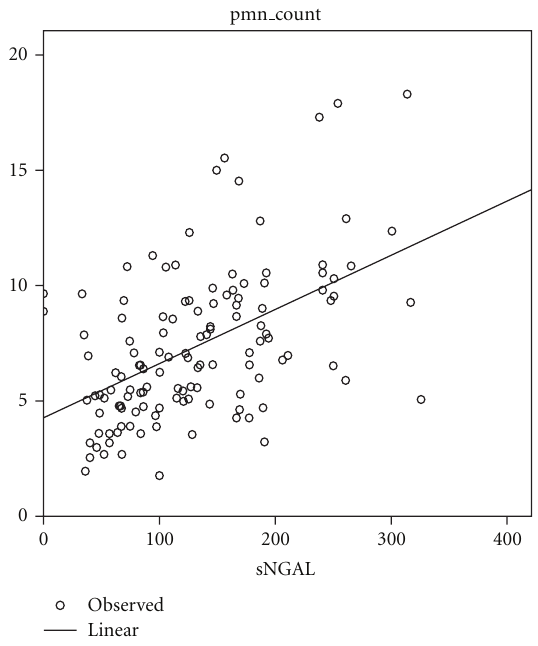
Figure 4: Scater plots of PMN values versus serum NGAL.